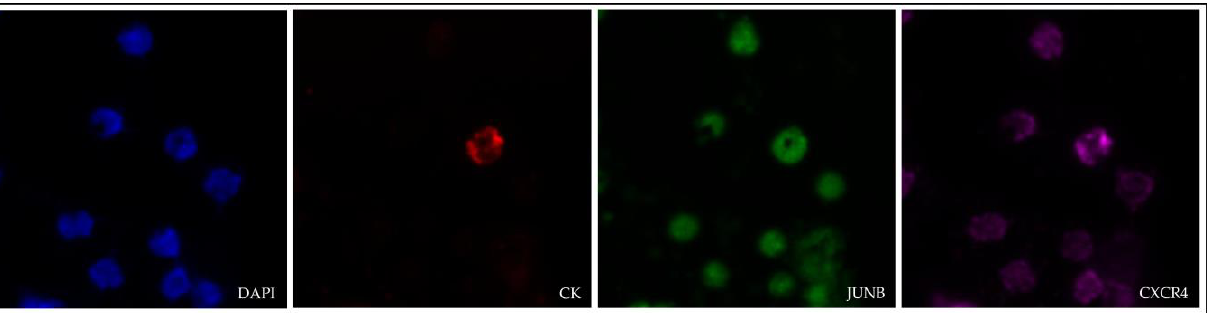
Figure 4. Cytokeratin (red), JUNB (green) and CXCR4 (purple) expression in a CTC isolated from a SCLC patient (VyCAP imaging system). Nuclei (blue) were stained with DAPI. Magnification 40X.